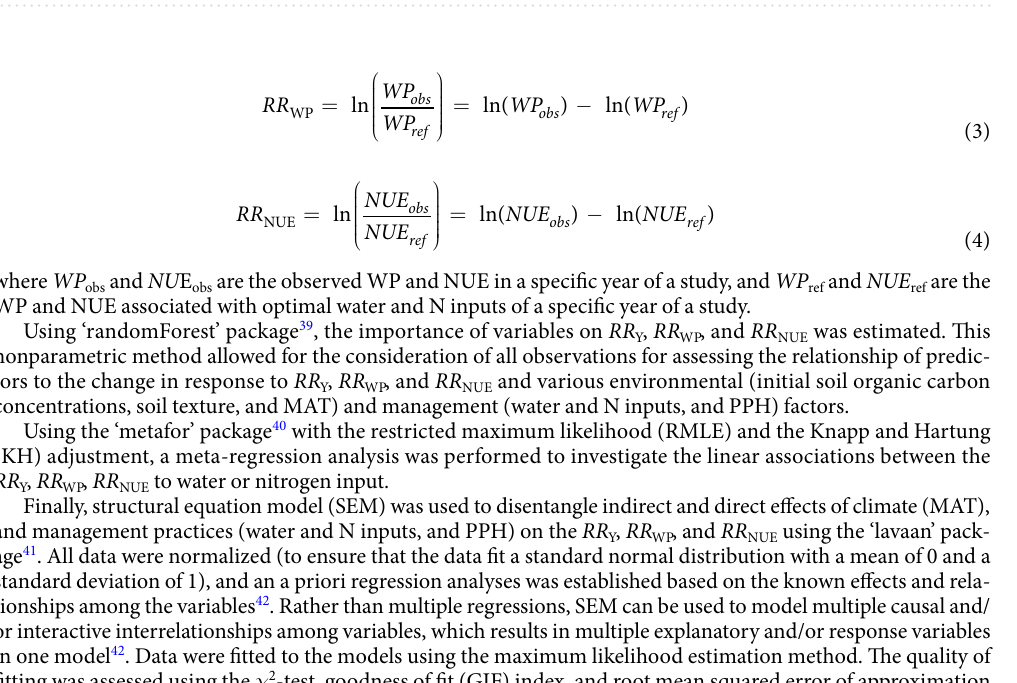
Figure 7. Structural equation model showing the direct and indirect effects of environmental and management conditions on the response ratio of yield ( RR Y ), water productivity ( RR WP ) and nitrogen use efficiency ( RR NUE ). Response ratio stands for effect size between the treatment and control and is calculated using Eqs. 2–4. Numbers at arrows are standardized path coefficients. Numbers next to boxes indicate the variance explained by the model (R 2 ). MAT, mean annual temperature; PPH, maize planting density (number of plants per hectare). Water, total water input; Nitrogen, total nitrogen inputs. χ 2 = 0.21; GFI = 0.998, AIC = 246.9, RMSEA = 0.05. The quality of fitting was assessed using χ 2 -test, the goodness of fit (GIF) and root mean squared error of approximation (RMSEA) indices, and Akaike information criterion (AIC) values, see details at